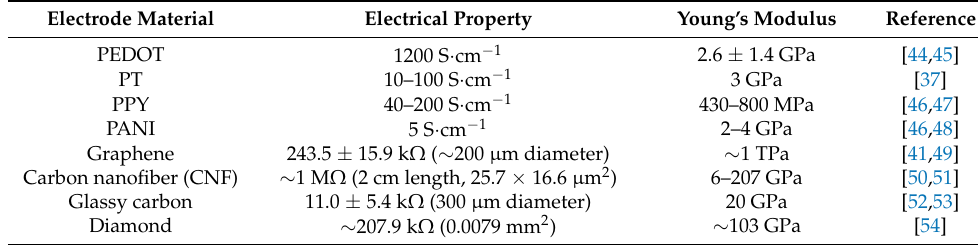
Table 1. A summary of the flexible electrode